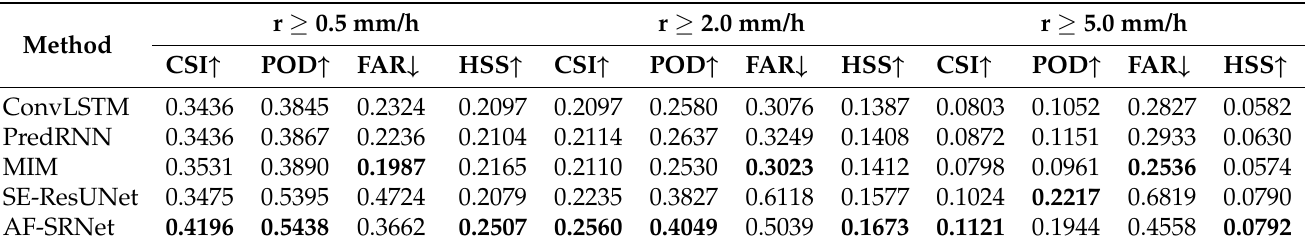
Table 4. Average evaluation results of two frames of precipitation amount nowcasting in the first two hours. The best performance is highlighted in bold. ” ↑ ” means that the higher the score, the better, while “ ↓ ” means that the lower the score, the